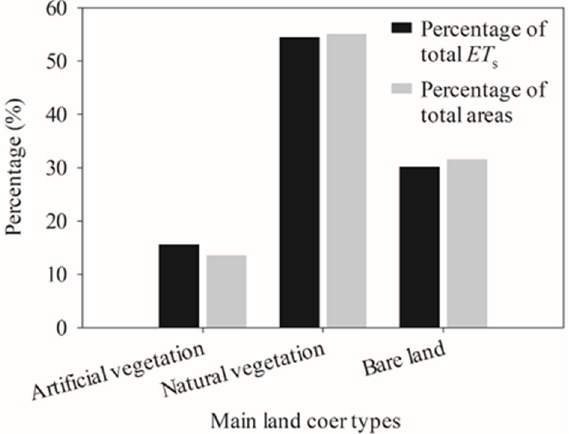
Figure 7. Percentage of artificial vegetation (farmland), natural vegetation, and bare land in the total study area, and the percentage of ET S in ET in three land cover types (artificial vegetation, natural vegetation, and bare land).